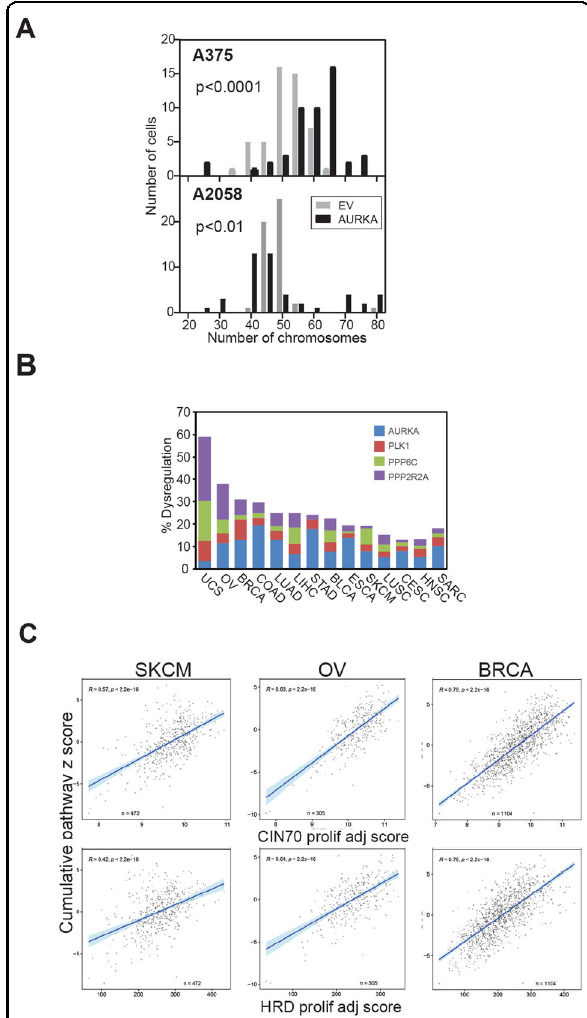
Fig. 6 PP6C-AURKA-PLK1 dysregulation promotes chromosomal instability. A Histograms of the numbers of chromosomes in the isogenic A375 and A2058 pairs, counted in 50 mitotic chromosome spreads for each line. B The bars represent the cumulative dysregulation of PPP6C , AURKA , PLK1 and PPP2R2A /B55 α as a percentage of total cases in TCGA pan cancer data set. BLCA, bladder cancer; BRCA, breast cancer; LIHC, liver hepatocellular carcinoma; LUAD, lung adenocarcinoma; CESC, cervical squamous cell carcinoma; COAD, colorectal adenocarcinoma; ESCA, oesophageal adenocarcinoma; HNSC, head and neck SCC; Liver, Liver hepatocellular carcinoma; LUSC, lung SCC; OV, ovarian cancer; STAD, stomach adenocarcinoma; SKCM, melanoma; UCS, Uterine carcinoma; SARC, sarcomas. C Correlation of the cumulative pathway score for PPP6C - AURKA - PLK1 - PPP2R2A and CIN70 and HRD proliferation adjusted (prolif adj) scores for the indicated tumour types from